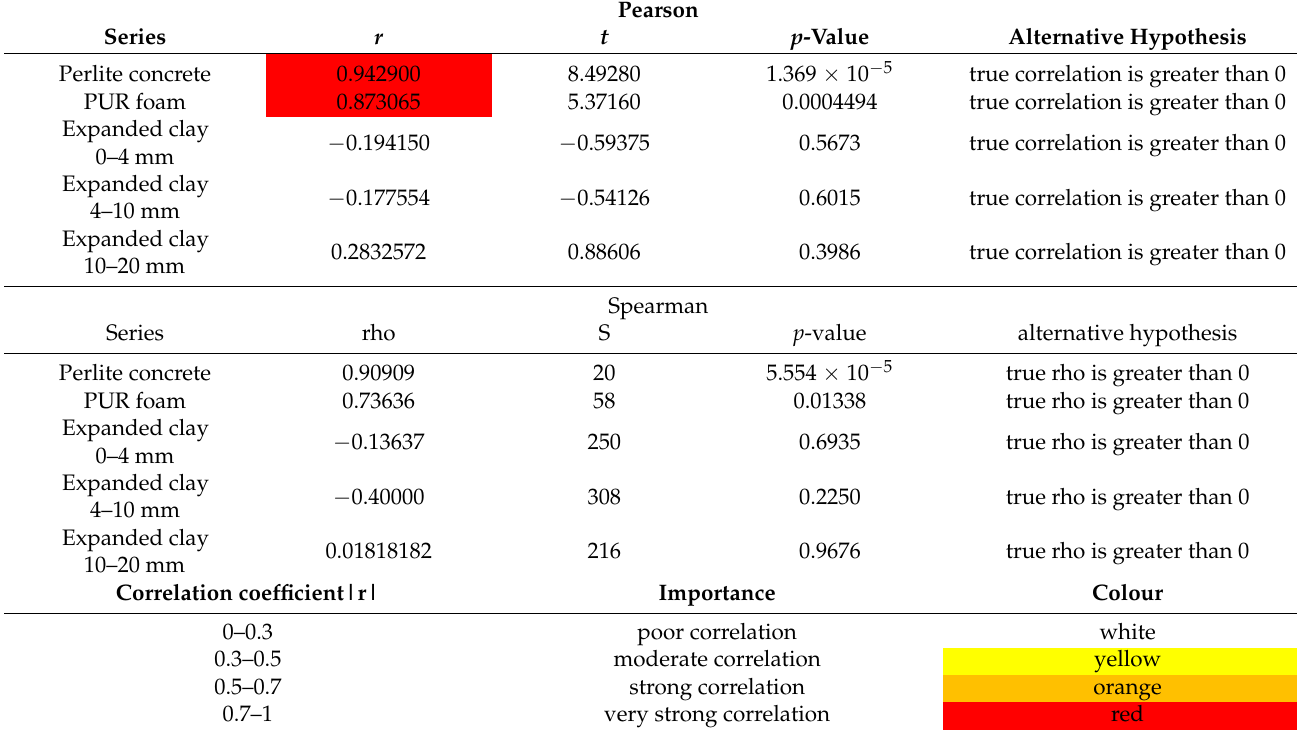
Table 3. Results of the non-parametric test of the correlation coefficient